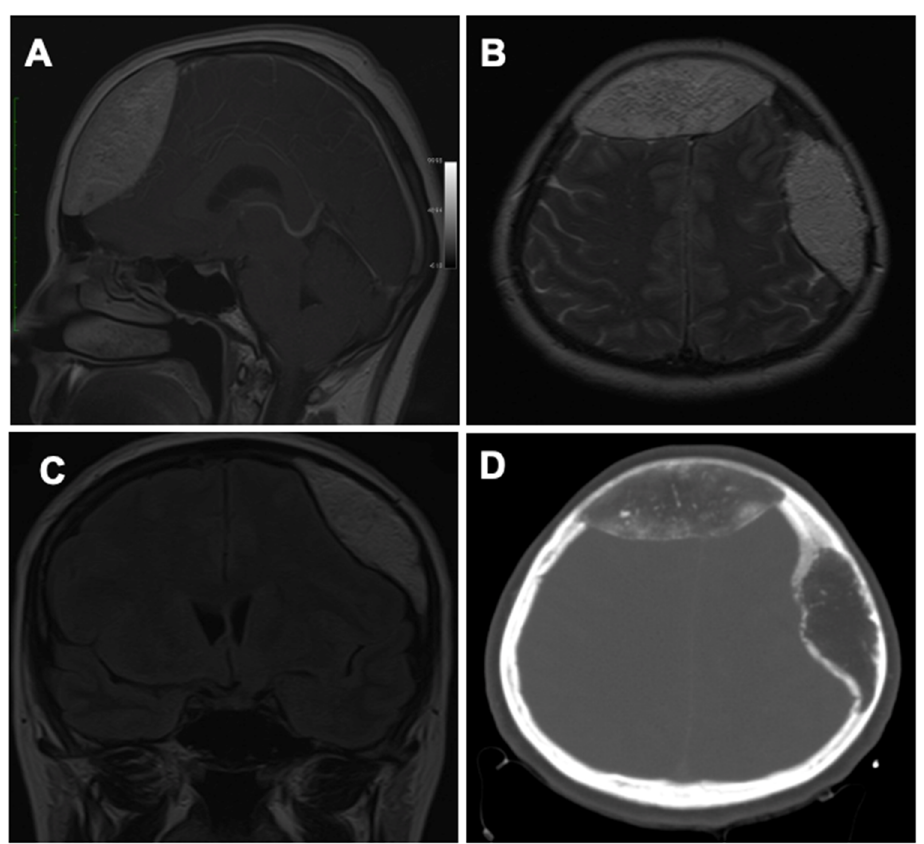
Figure 1. Preoperative neuroimaging: ( A ) Sagittal MRI scan showing the frontal lesion. ( B ) Axial MRI scan showing both the frontal and the parietal lesions. ( C ) Coronal MRI scan showing the parietal lesion. ( D ) Axial CT scan highlighting the hypodense aspect of frontal and parietal osseous lesions.